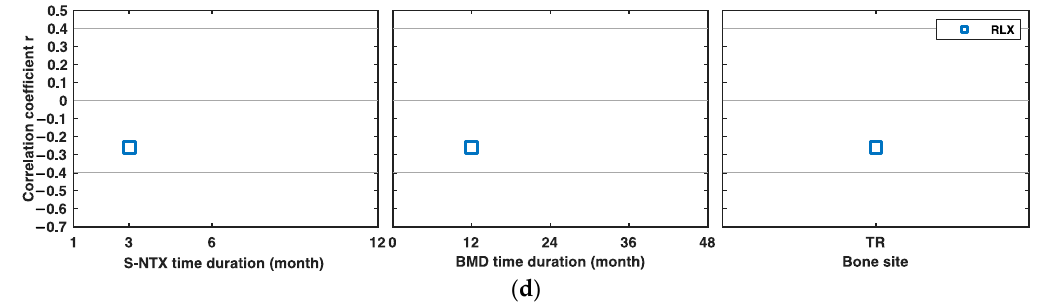
Figure 5. Significant correlations between the changes in BRMs and BMD at different bone sites under different drug interventions over time. ( a ) Correlations between the changes in urine N-terminal crosslinking telopeptide of type I collagen (U-NTX) and BMD from baseline at different bone sites under different drug interventions over time. ( b ) Correlations between the changes in U-CTX and BMD under different drug interventions over time. ( c ) Correlations between the changes in S-CTX and BMD under different drug interventions over time. ( d ) Correlations between the changes in S-NTX and BMD under different drug interventions over time. ALN alendronate, ALN5 5 mg/d ALN, ALN10 10 mg/d ALN, ALN10+HRT, combination of 10 mg/d ALN and HRT, BRM bone resorption marker, CTX serum C-terminal crosslinking telopeptide of type I collagen, DMAB denosumab, HRT hormone replacement therapy, RLX raloxifene, TPTD teriparatide, FN femoral neck, LS lumbar spine, S-CTX serum CTX, U-CTX urine CTX, TB total body, TH total hip, TR trochanter.